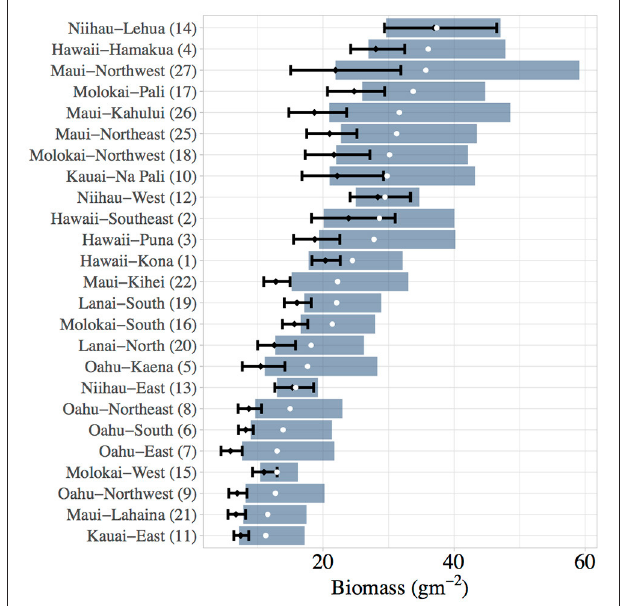
FIGURE 5 | Region-scale (i.e., overall) effect of all drivers on total (red) and herbivorous (blue) reef fish log biomass in our hierarchical model for the main Hawaiian Islands. Mean (circle) and 66% Bayesian Credible Intervals (whiskers) are shown for each driver.